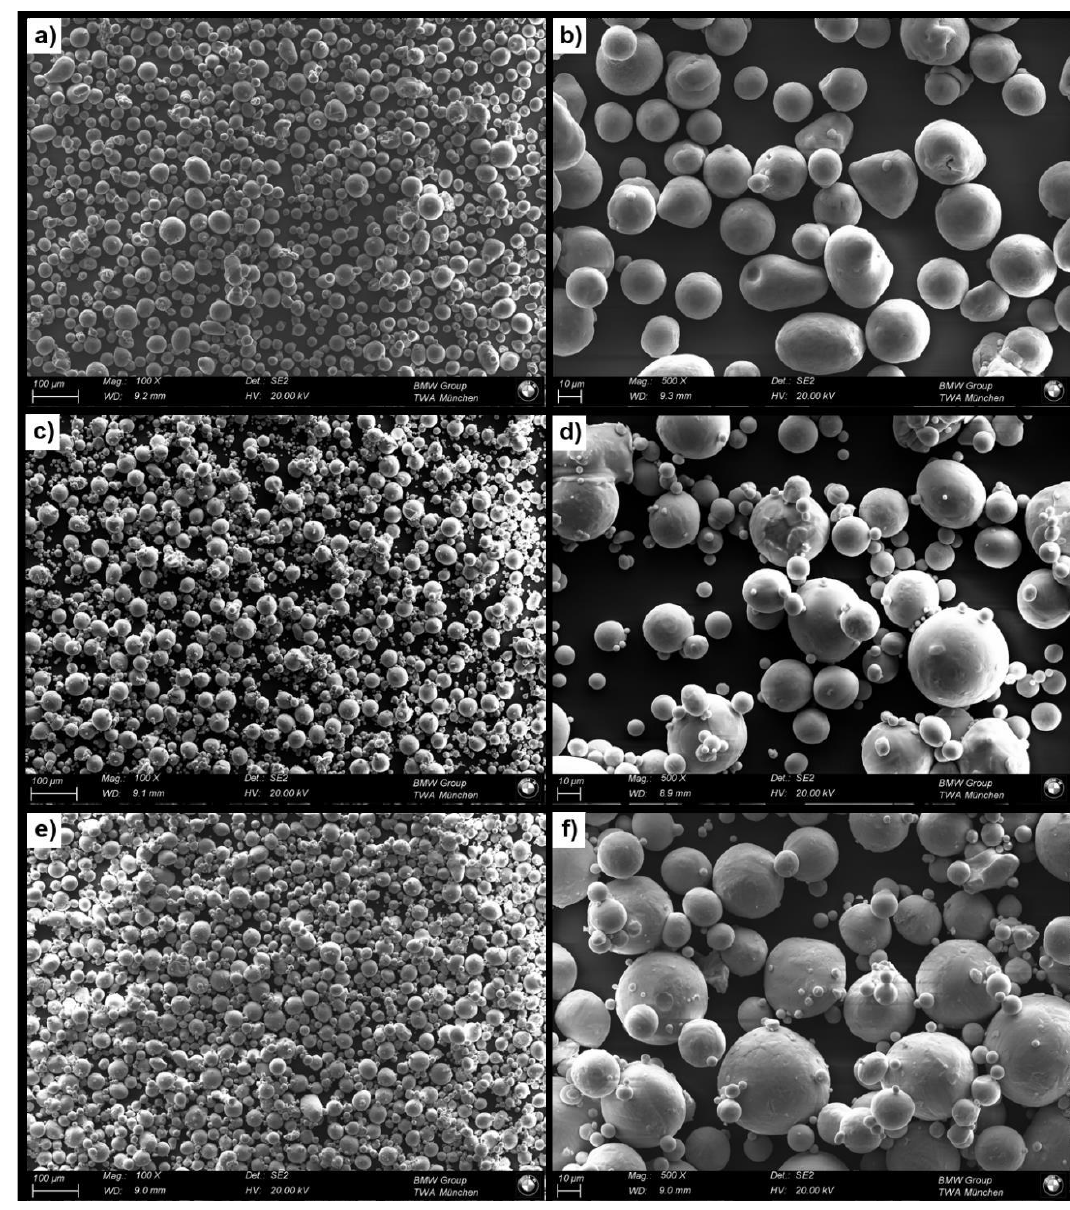
Figure 1. ( a – f ). Scanning electron micrographs of the powders in two magnifications: ( a , b ) 6182 powder; ( c , d ) Ti powder; and ( e , f ) Zr powder.